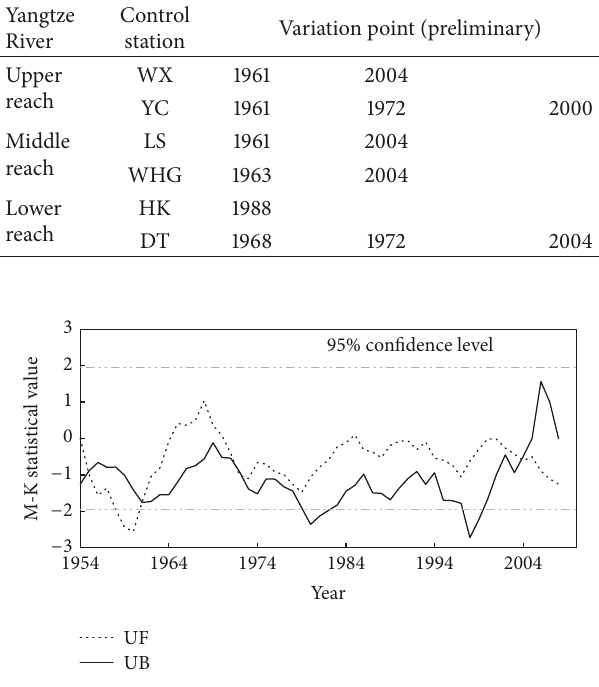
Figure 3: WX station’s runoff Mann-Kendall test.